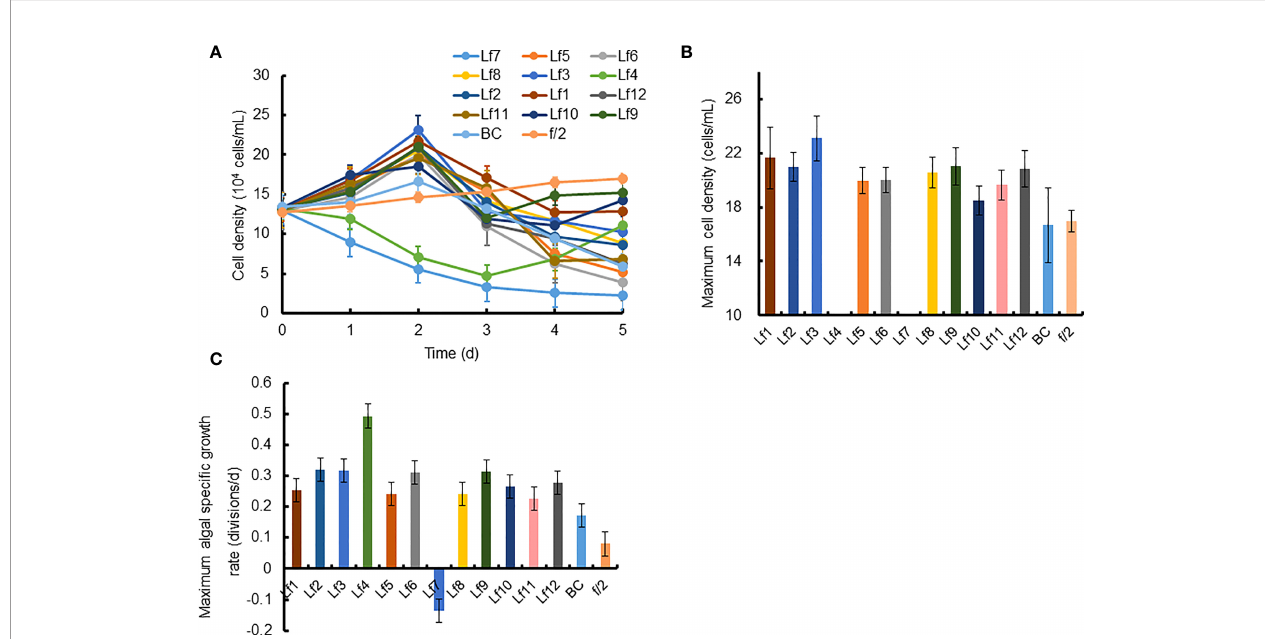
FIGURE 2 | The growth of Chaetoceros curvisetus in the co-culture of bacterial strains isolated from the phycosphere of Levanderina fi ssa including (A) Growth curve, (B) maximum cell density, and (C) maximum speci fi c growth rate. The maximum cell densities were not shown in Lf4 and Lf7, whose cell numbers were always lower than the initial cell numbers during the experiment. Lf1-Lf12: Cultures addition of the 12 bacterial strains Lf1-Lf12, BC: Culture addition of the liquid Zobell 2216E medium, f/2: Growth in f/2